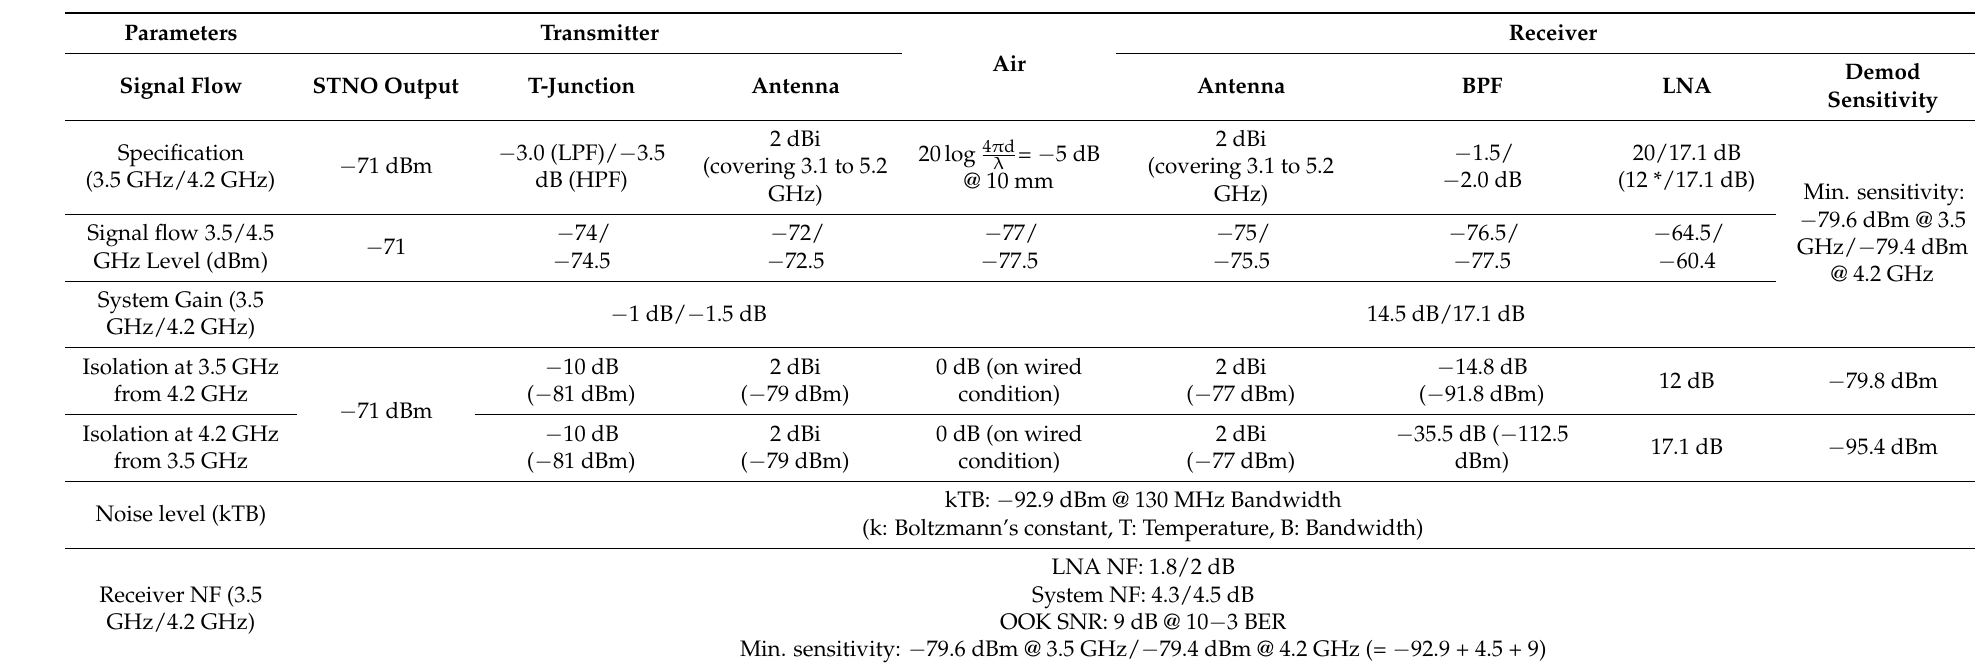
Table 1. The specification and the signal flow in the receiver and